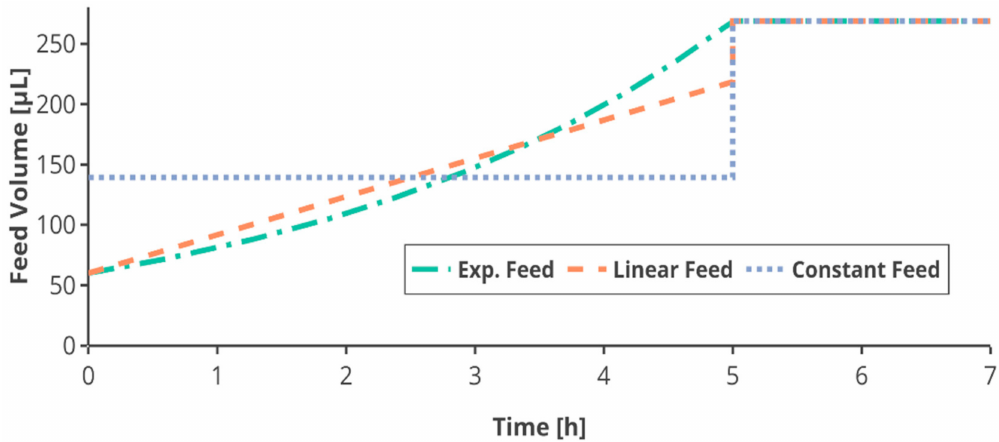
Figure 2. Schematic overview of the feed profiles. In the first feed phase exponential, linear or constant feed is applied according to the experimental plan, followed by a constant feed (here after 5 h) for all cultivations in the second feed phase. As the calculation of the linear and constant feed is based on the respective exponential feed, all cultivations receive the same amount of glucose during the cultivation, relative to the biomass concentration at the feed start. Interactive versions of the plots can be found online